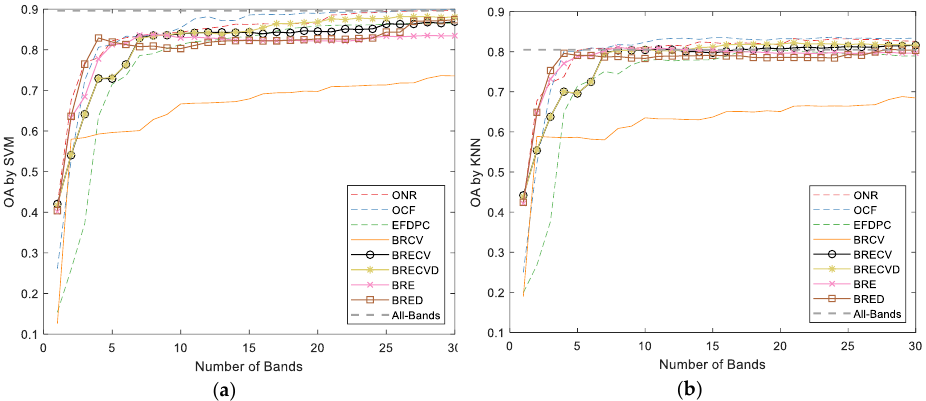
Figure 2. Overall accuracy (OA) curves produced by support vector machine (SVM) and k-nearest neighborhood (KNN) classifiers for the Indian Pines data set. ( a ) The OA curves produced by SVM classifier. ( b ) The OA curves produced by KNN classifier.